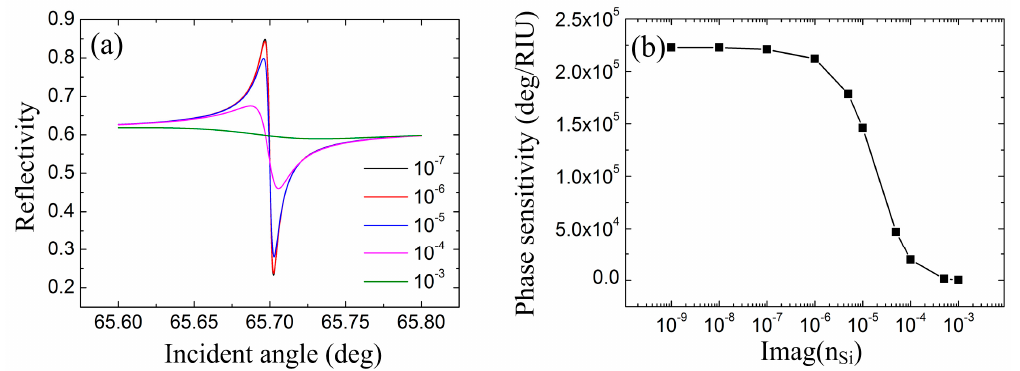
Figure 7. ( a ) ATR curves near FR angle and ( b ) phase sensitivity with considering different imag( n Si ).